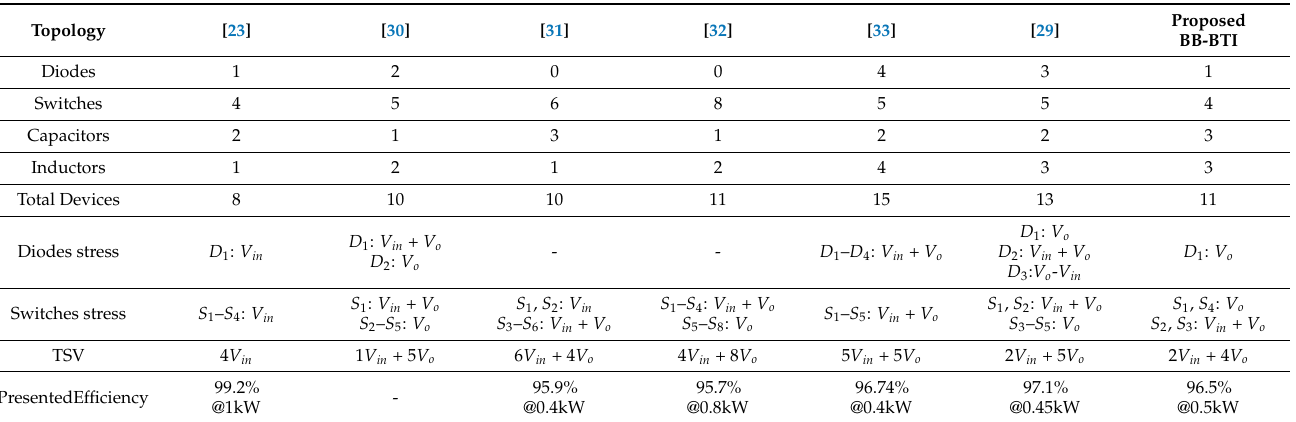
Table 3. Comparison between the proposed single-stage BB-BTI and other common-ground trans- formerless